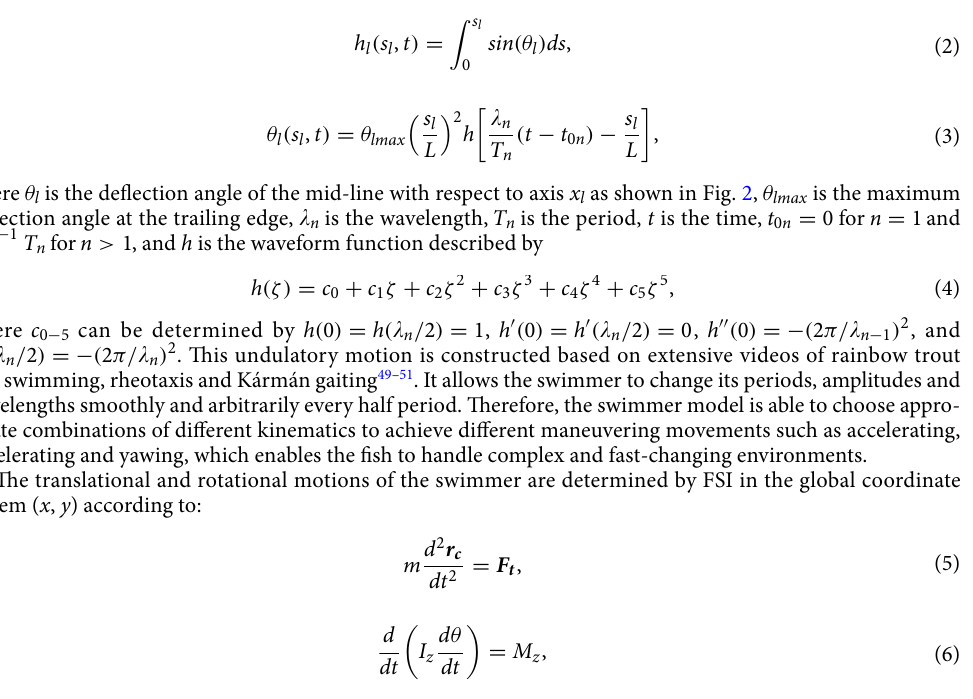
where L is the body length, and s l is the arc length along the mid-line of the body. The motion of the body includes three parts as shown in Fig. 2: the undulation motion of the body ( h l in x l – y l system), the translation of the mass center ( r c ), and the body rotation around the mass center ( θ ). The undulatory motion can be taken as the superposition of different waves propagating from head to tail. In order to implement the DRQN in an easy way as explained later, every wave lasts only half cycle. In the n -th half cycle, the mid-line lateral displacement is determined by